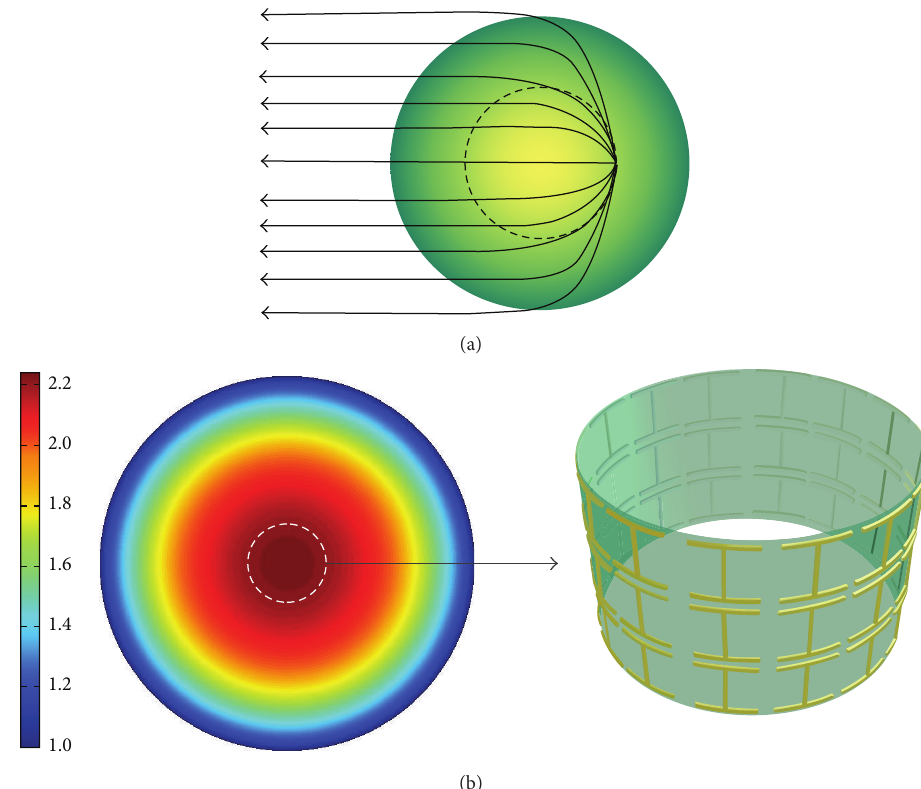
Figure 1: (a) Ray trajectories through the modified Luneburg lens, where the source is located inside the lens. (b) Refraction index profile for the modified Luneburg lens; the inset shows one of the concentric layers of the designed